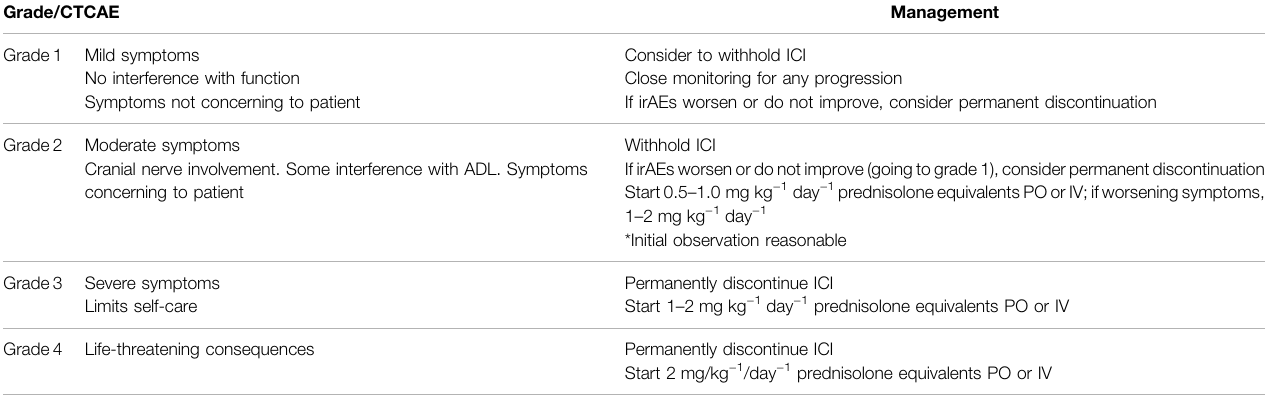
TABLE 3 | Management of suspected neurological immune-related adverse effects (irAEs) Grade/CTCAE